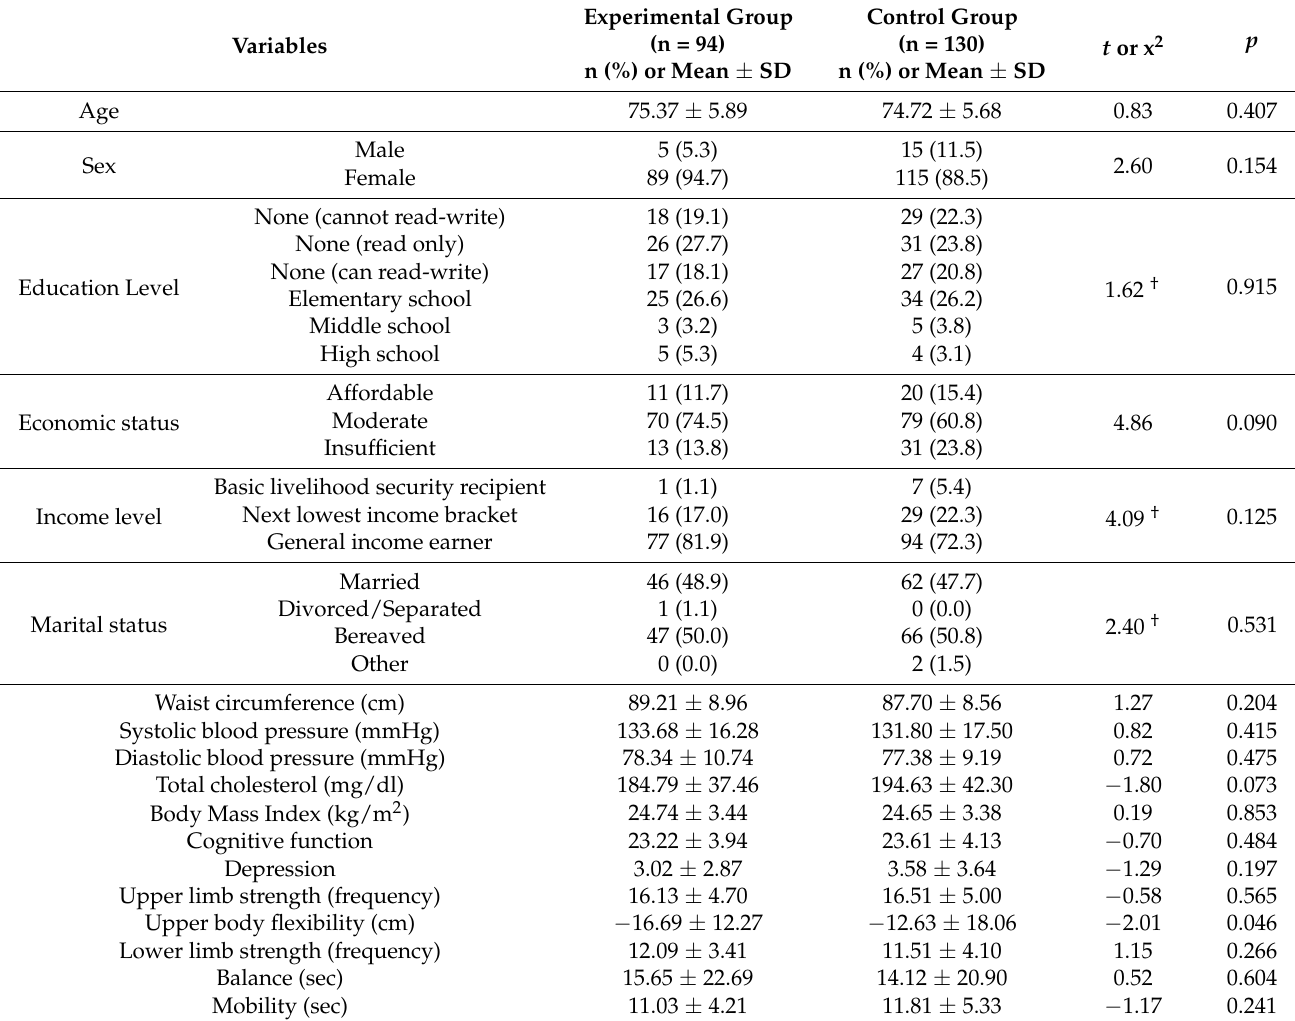
Table 1. Homogeneity test for general characteristics and dependent variables at baseline between two